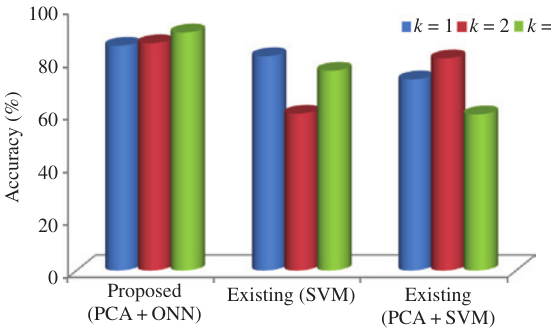
Figure 10: Comparison Results for Various Existing Methods.